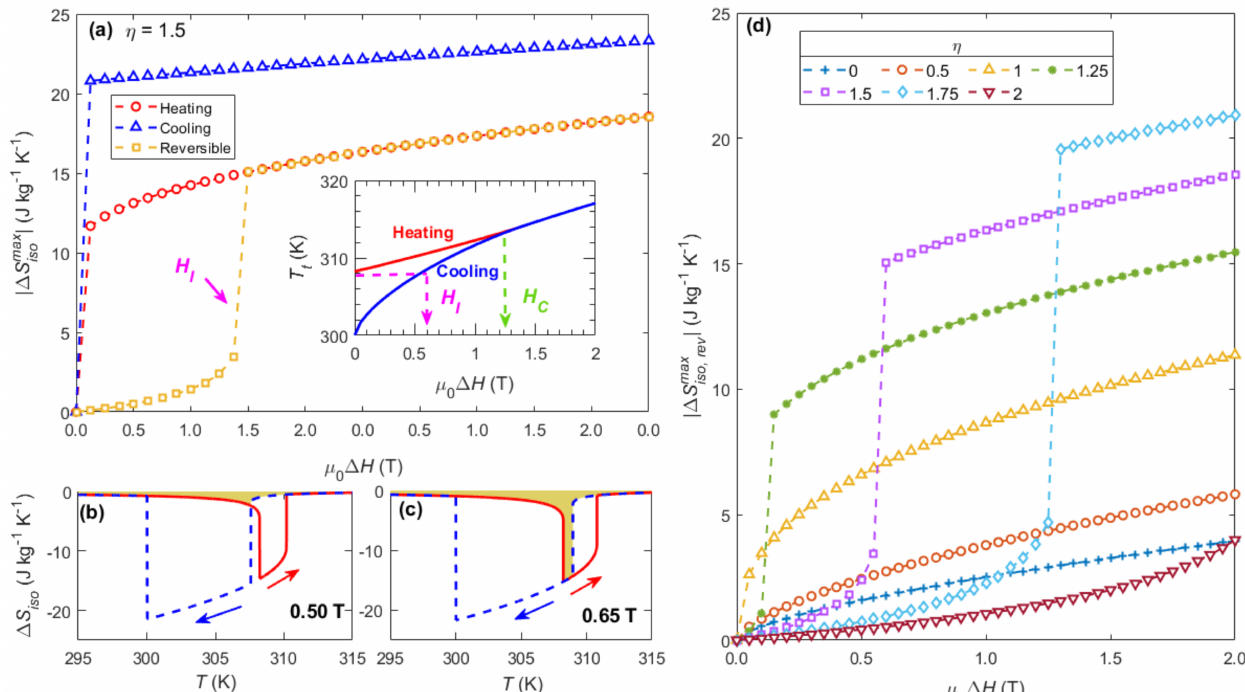
Figure 2. ( a ) Magnetic field dependence of the maximum value of ∆ S iso and the evolution of the transition temperatures (inset) for η = 1.5 and m = 7 µ B ; ( b ) Temperature dependence of ∆ S iso for η = 1.5 at 0.5 T and ( c ) 0.65 T; ( d ) Magnetic field dependence of maximum reversible ∆ S iso for different η values and m = 7 µ B